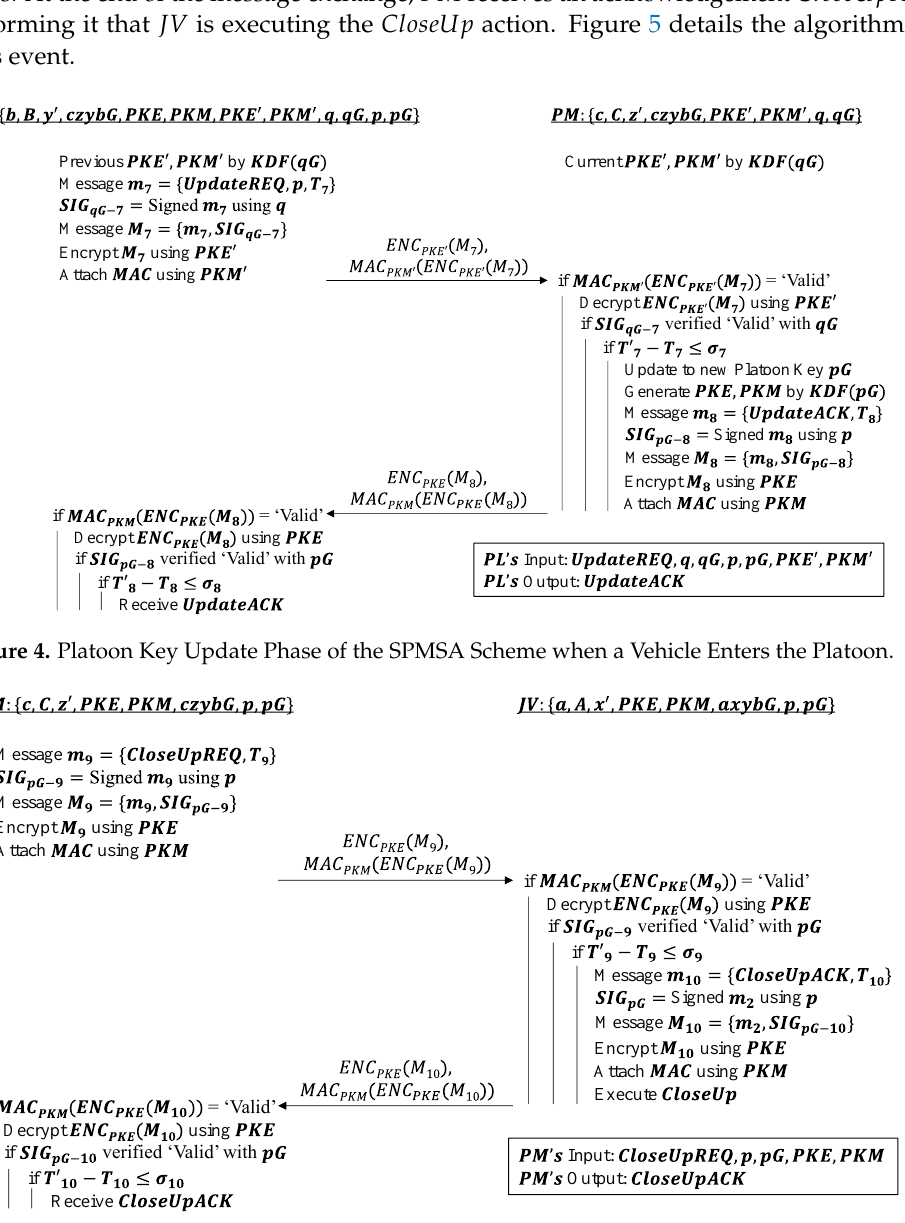
Figure 5. Platoon Communication Event of the SPMSA Scheme.